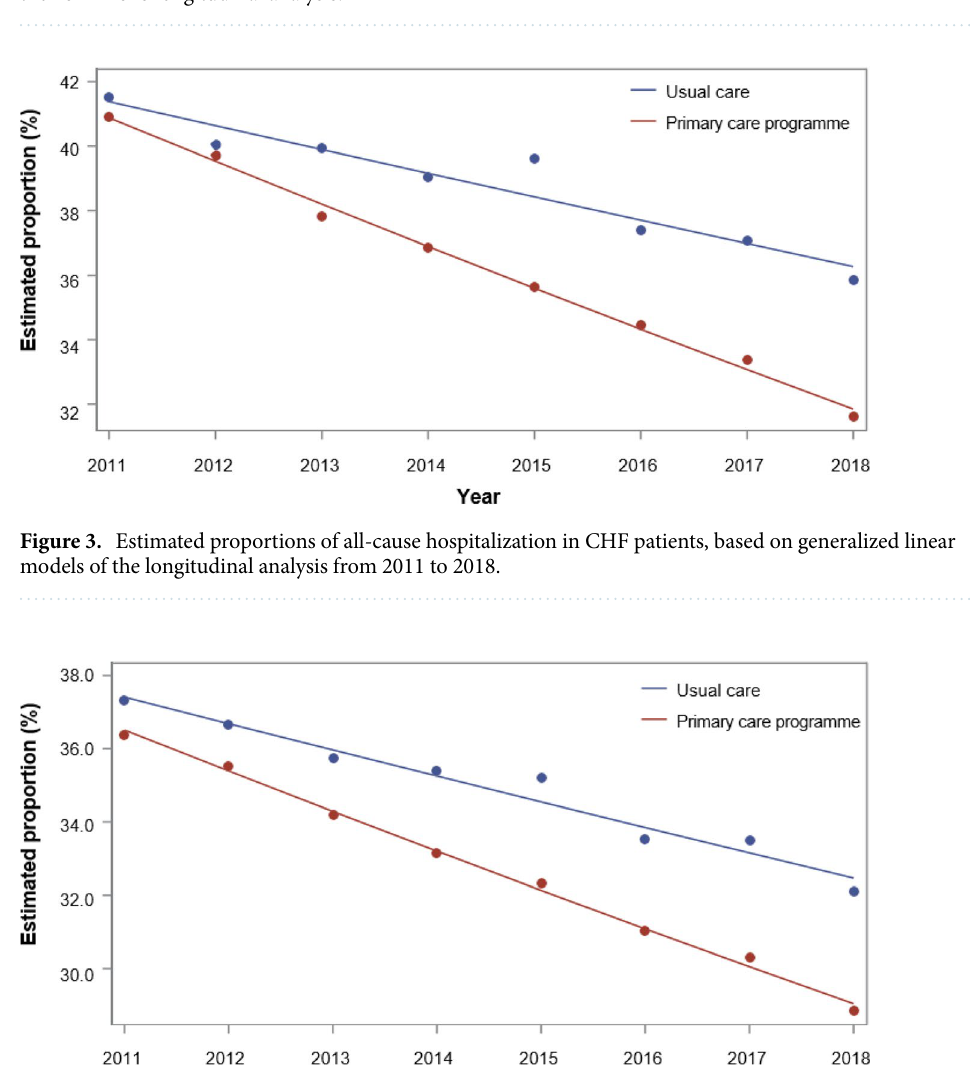
Figure 2. Estimated proportions of all-cause hospitalization in diabetics, based on generalized linear models of the 2011–2018 longitudinal analysis.